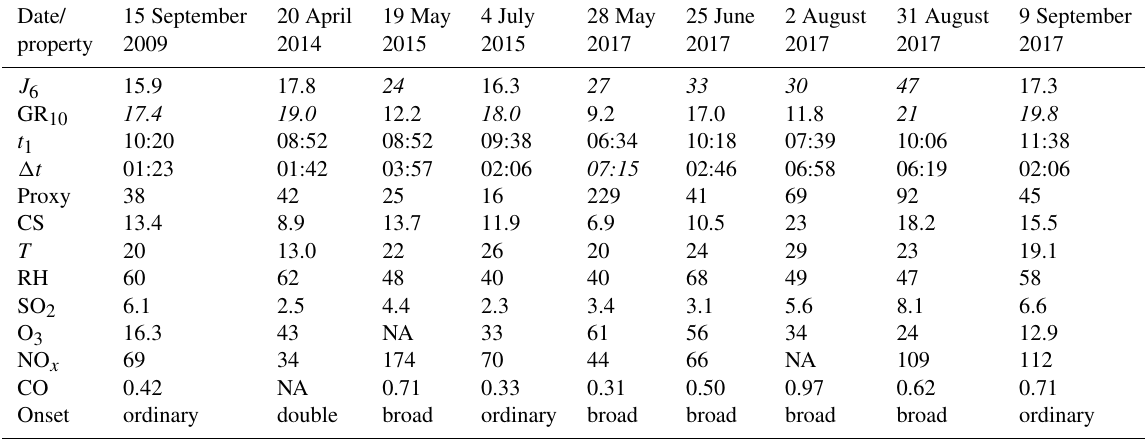
Table 3. Date, new particle formation rate J 6 (in units of cm − 3 s − 1 ), particle diameter growth rate GR 10 (nmh − 1 ), starting time t 1 of nu- cleation (HH : mm UTC + 1), duration time interval (cid:49)t = t 2 − t 1 of nucleation (HH : mm), mean condensation sink CS during the nucleation process (10 − 3 s − 1 ), daily maximum gas-phase H 2 SO 4 proxy (10 4 µgm − 5 Ws), daily mean air temperature T ( ◦ C), daily mean relative humidity RH (%), daily median concentrations of SO 2 , O 3 , NO x (µgm − 3 ) and CO (mgm − 3 ) gases and the type of the onset for extreme quantifiable NPF and growth events. The numbers in italics indicate the values which are above the 98% percentile of the corresponding data sets. NA: not